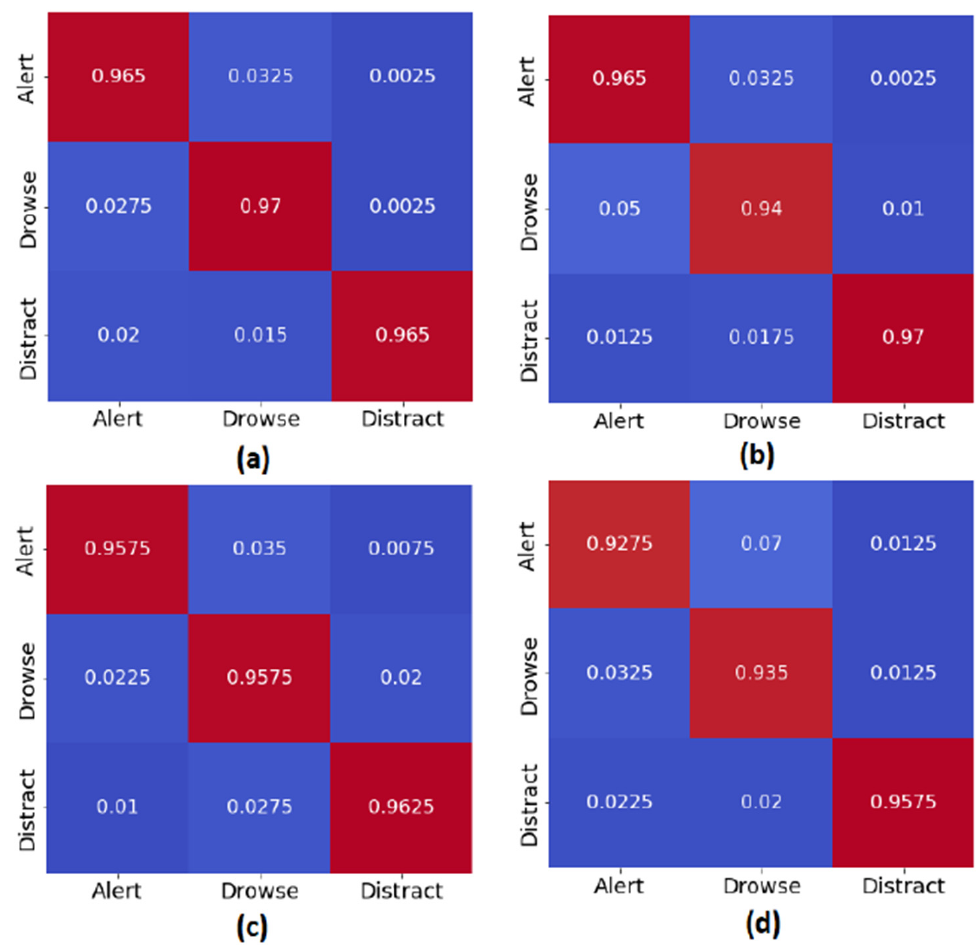
Figure 23. Confusion matrices under four different conditions. ( a ) Without glasses under normal illumination, ( b ) with glasses under normal illumination, ( c ) without glasses under IR illumination, and ( d ) with glasses under IR illumination.